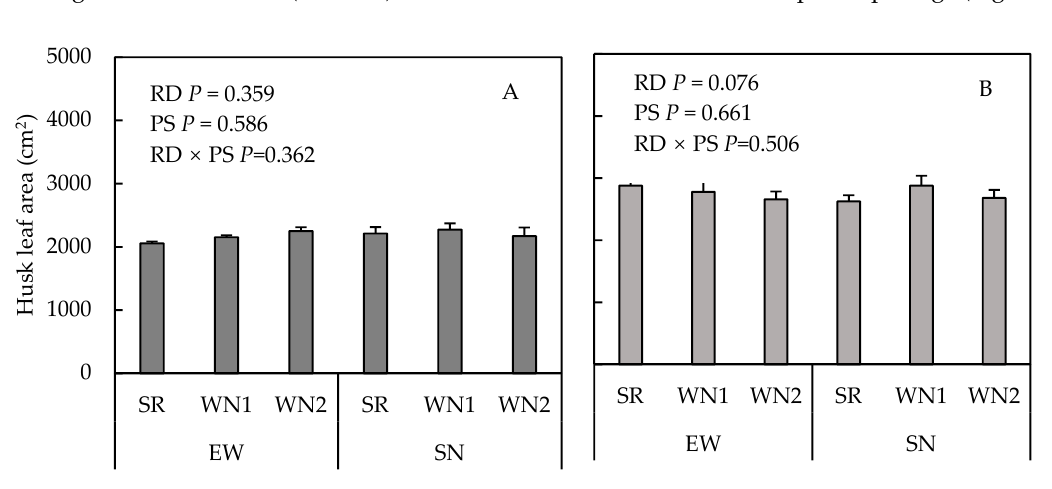
Table 2. Out-put of one-way analysis of variance (ANOVA) for stages on superoxide dismutase (SOD), polyphenoloxidase (POD), and catalase (CAT) activities; abscisic acid (ABA) concentration; and SPAD value at days after silking (DAS )12, 22, and 40, as well as the dehydrating rate from DAS 12 to 22 and DAS 22 to 40.